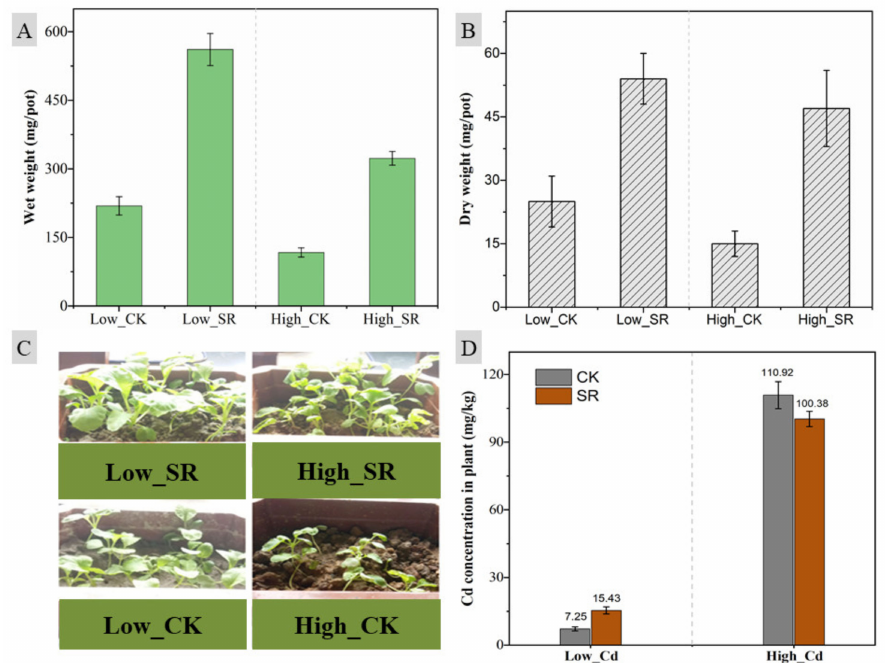
Figure 4. The effects of fungal inoculation on the growth of plant samples: ( A ) The wet weight and ( B ) the dry weight of all plant samples in a pot; ( C ) Plants in the pots before sampling; ( D ) The Cd concentration of the dry